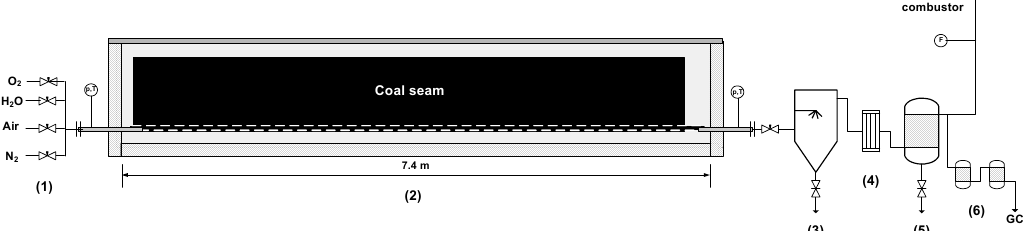
Figure 1. Scheme of the experimental installation: (1) supply of reagents, (2) gasification reactor, (3) scrubber, (4) cooler, (5) dust separator, (6) gas filters.